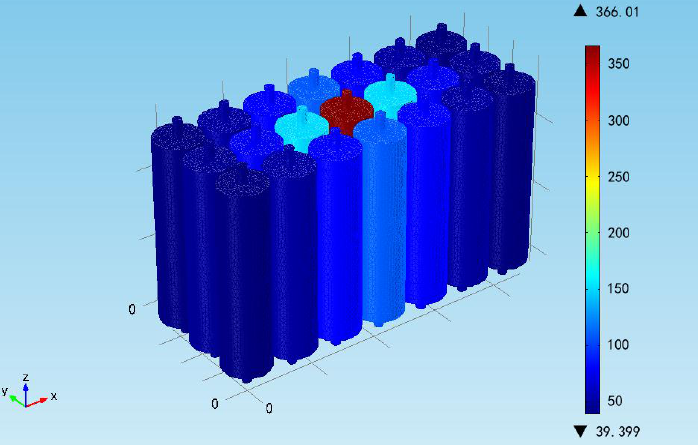
Figure 11. Temperature distribution of the battery module (the units are